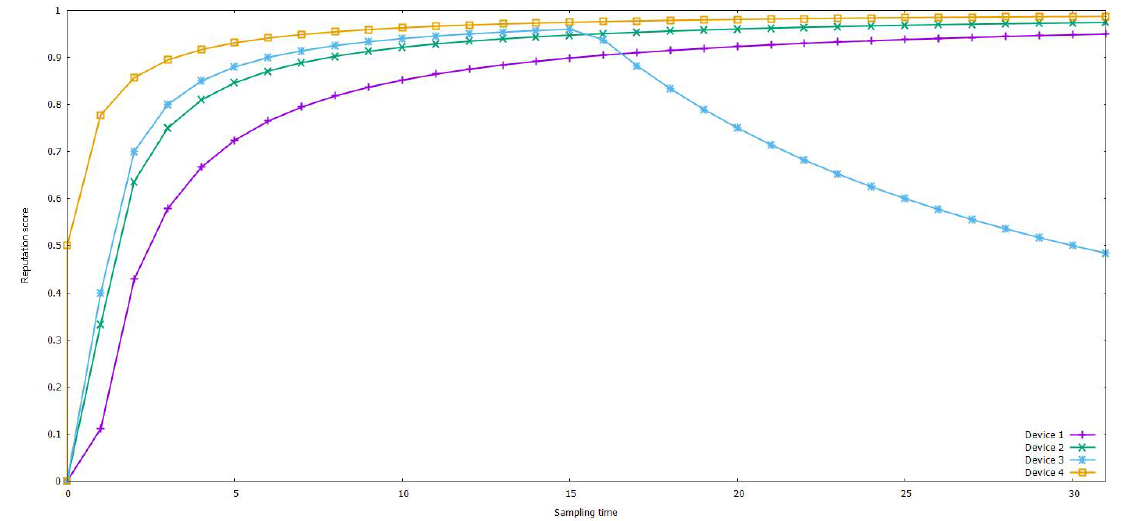
Figure 8. System reputation of each device, obtained in test 1.